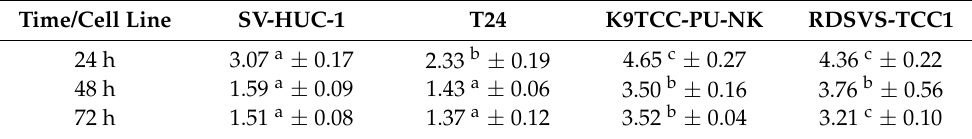
Table 1. Comparison of Degrasyn concentrations that inhibited 50% of the cell proliferation (IC 50 values ( µ M)) for all tested cell lines after 24, 48, and 72 h of exposure, evaluated with MTT assay. Time/Cell Line